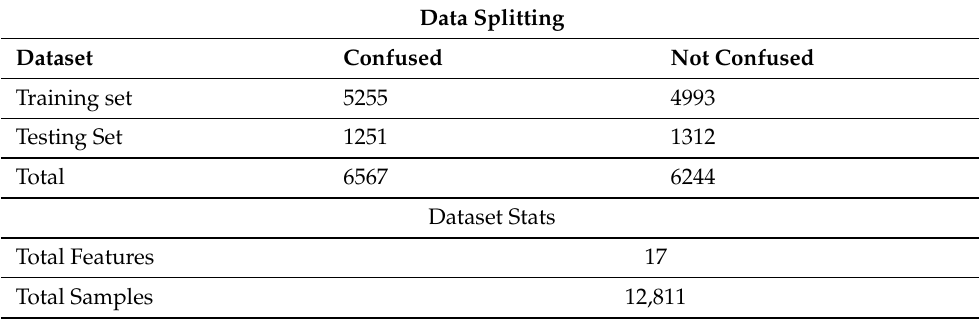
Table 2. Dataset details for training and testing.